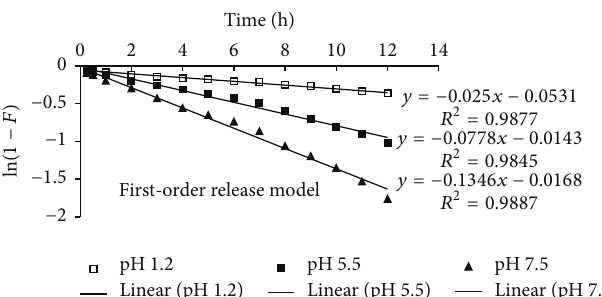
Figure 16: % log cumulative pheniramine maleate release ( 1 − 𝐹 ) versus time (first-order release) from EGDMA cross-linked AA/Gelatin hydrogels.